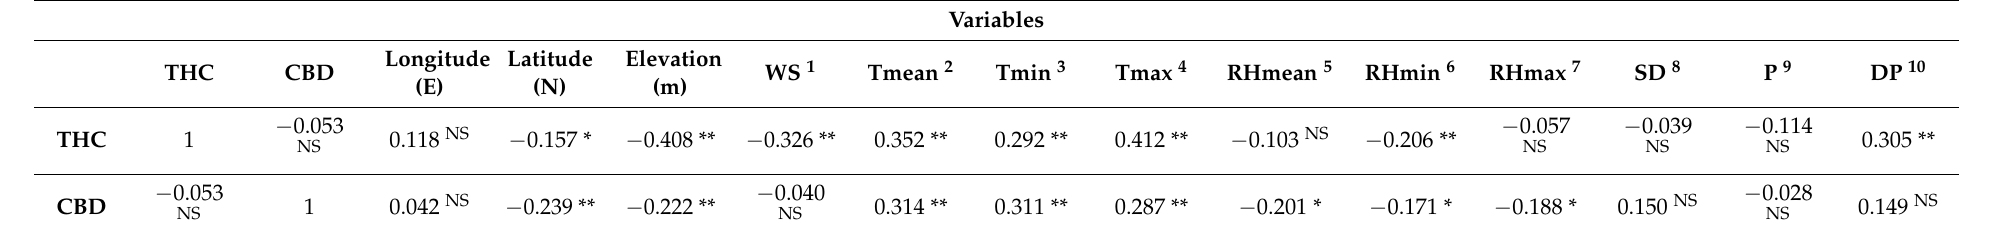
Table 1. Pearson correlation among geographical and climatic parameters with THC and CBD concentration in the studied cannabis plants.